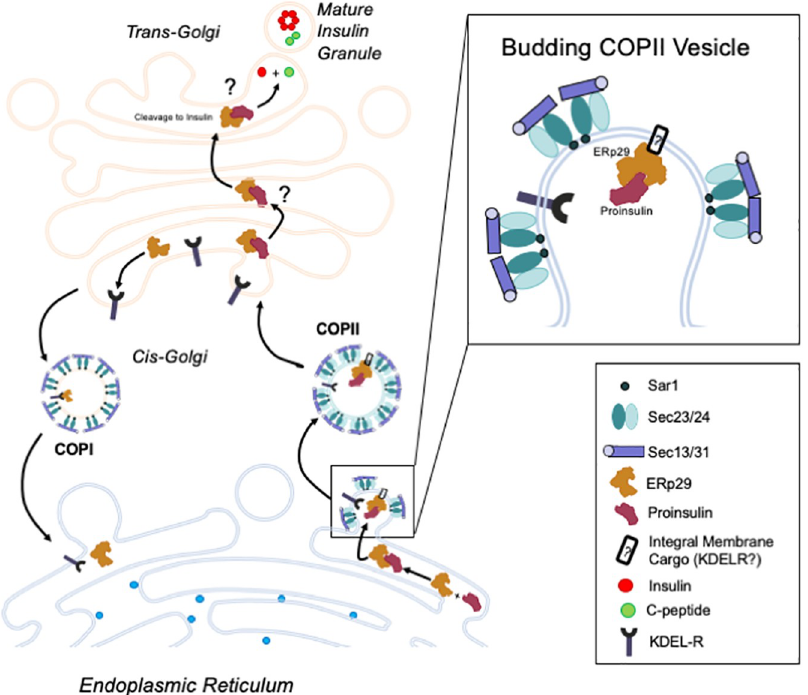
Fig 7. Hypothesized role for ERp29 in Insulin synthesis. Proinsulin (Red) is transported from the ER to the cis-Golgi via COP II vesicles; however, it is currently unclear how Proinsulin is recruited for inclusion in COP II vesicles. The Sec23/24 heterodimer is an essential component of the COP II vesicle pre-budding complex, which also includes Sar1 and the Sec13/31 heterodimer. Our data demonstrate that the Sec24 isoform, Sec24D, interacts with both ERp29 and Proinsulin in pancreatic β -cells, likely as part of a complex. We hypothesize that ERp29 interacts directly with Proinsulin at its putative ERp29 binding domain ( 24 F-F-Y 26 in Proinsulin) and promotes inclusion of the Proinsulin/ ERp29 complex in COP II vesicles. In this model, ERp29 also associates with a currently unknown integral membrane protein that intermediates the interaction of Proinsulin/ERp29 with Sec24D. One such integral membrane protein may be the KDEL receptor (KDEL-R), which cycles between the ER and cis-Golgi via COP I and II vesicles. Our group previously demonstrated that KDEL-R facilitates the transport of other COP II cargo, specifically the epithelial sodium channel, ENaC, from ER to Golgi, in concert with ERp29 and Sec24D. Future studies will test the hypothesis that KDEL-R intermediates the interaction of ERp29/Proinsulin with Sec24D. Our data also suggest that ERp29 may stabilize Proinsulin, perhaps as it transverses the Golgi cisternae to the trans-Golgi, where it is cleaved to mature Insulin and C-peptide and packaged into granules for